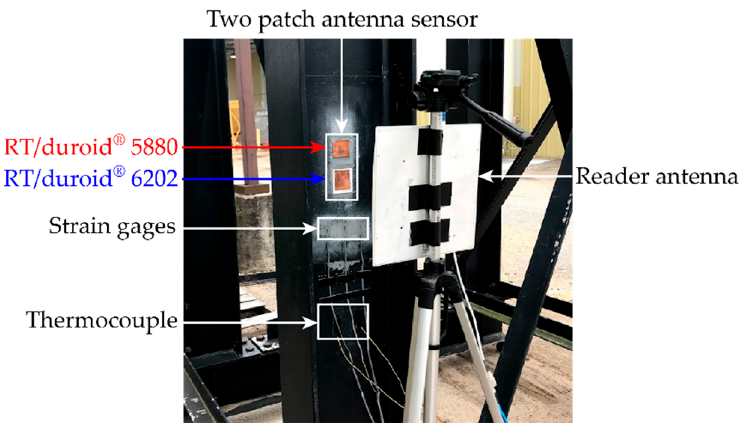
Figure 5. Experimental setup for outdoor temperature test.